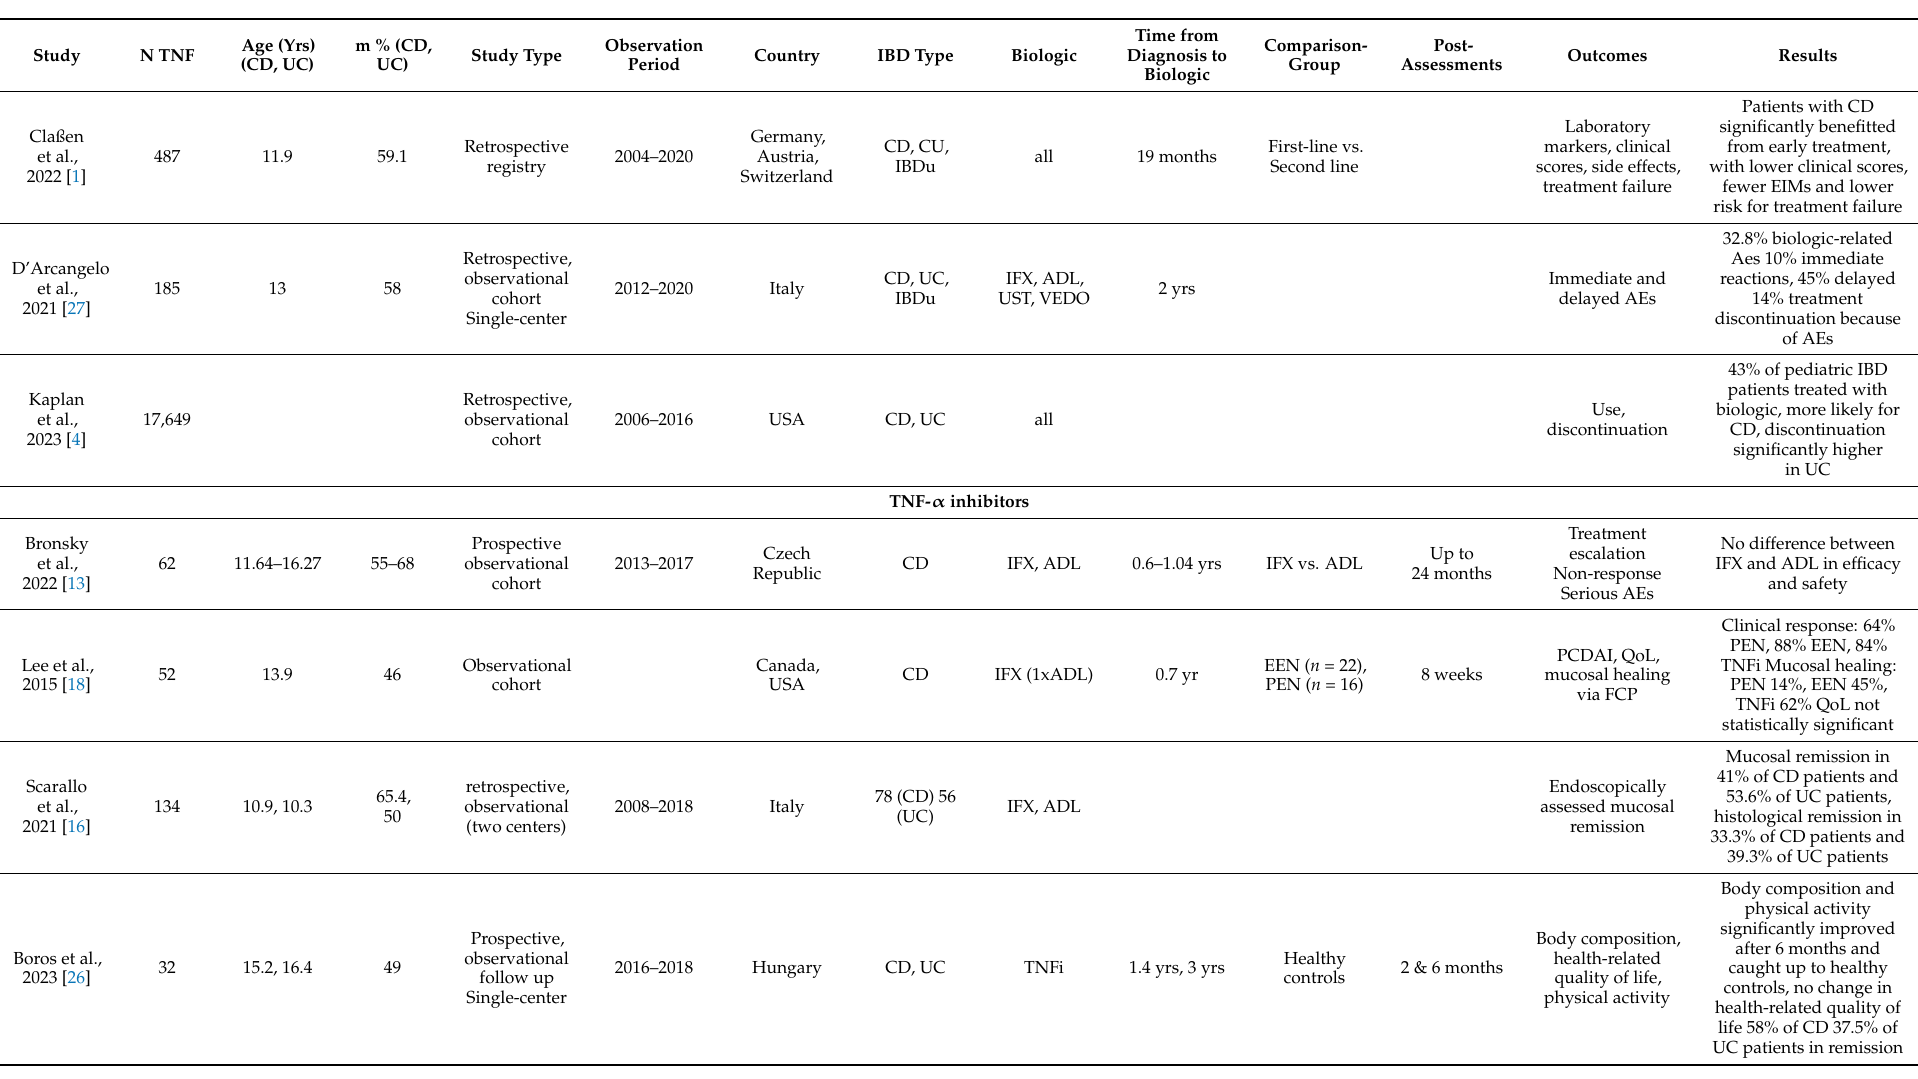
Table 1. All included studies with pediatric patients and